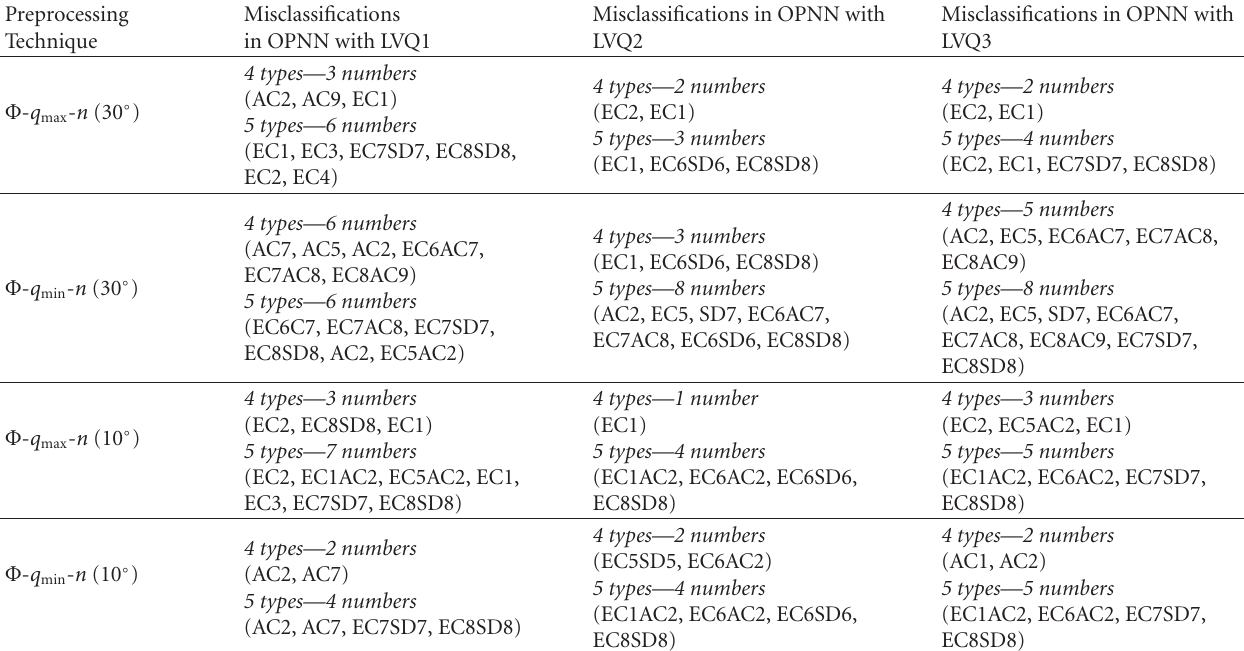
Table 4: Observations made on the classification capability of OPNN and APNN for moderate database—with clustering algorithm.